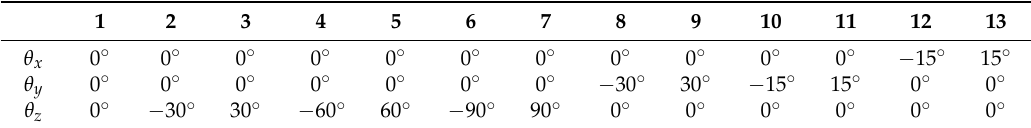
Table 2. The selected rotation angles of Model 1 in Scene 1.